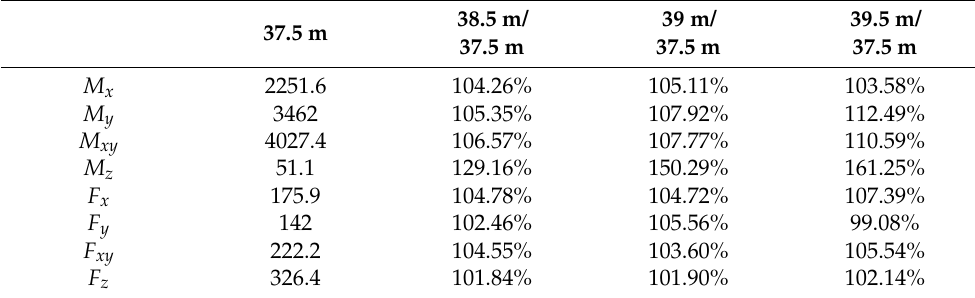
Table 7. Ultimate loads at blade root.